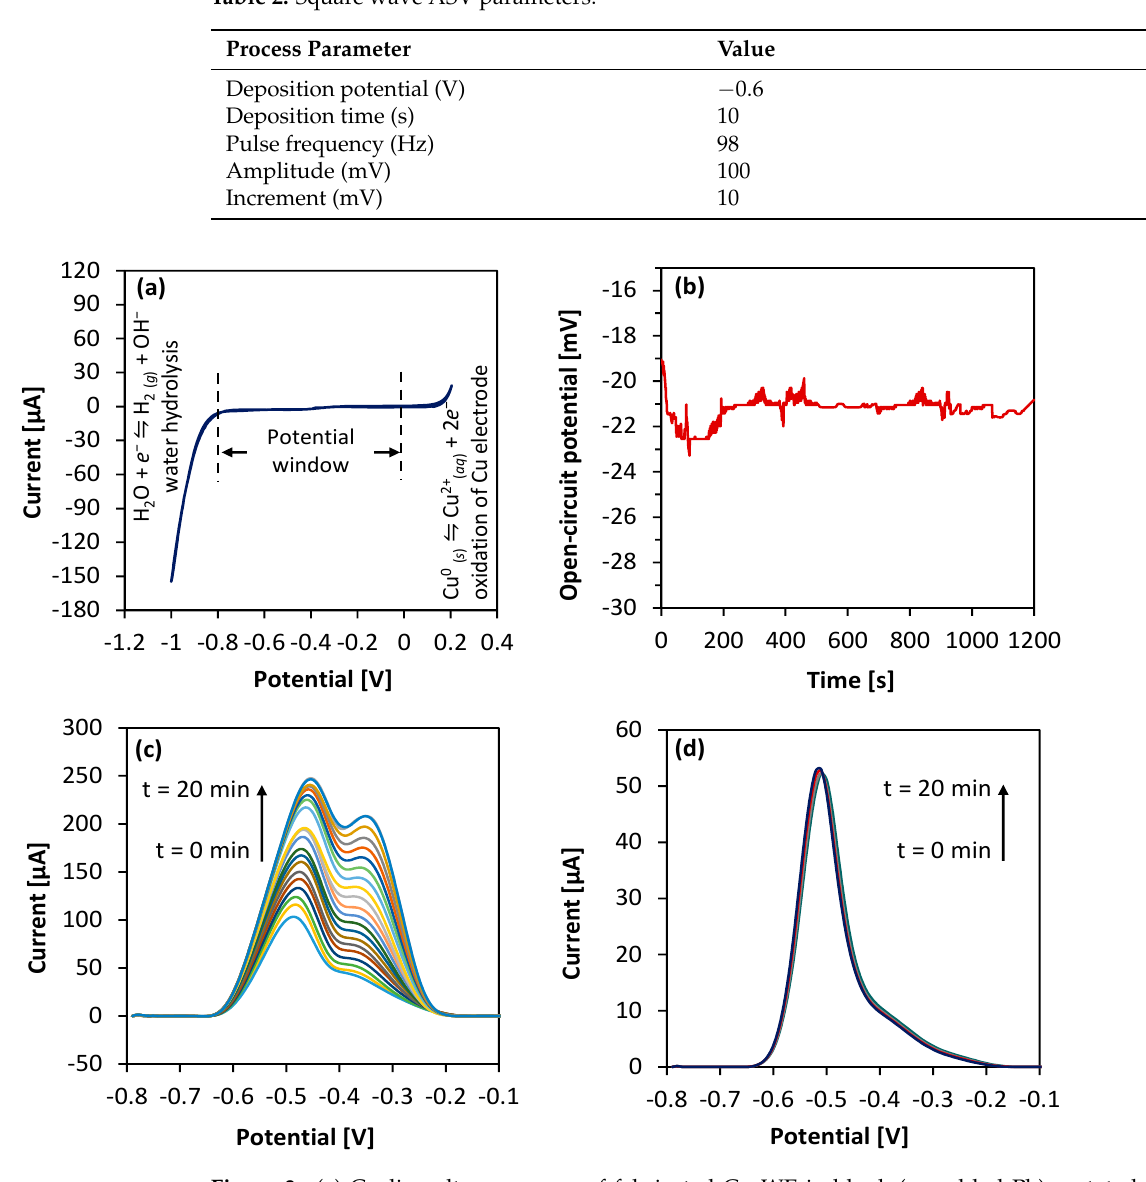
Figure 3. ( a ) Cyclic voltammogram of fabricated Cu WE in blank (no added Pb) acetate buffer. Scan rate was 100 mV/s, sweep voltage = − 1 V to + 0.2 V. ( b ) Open-circuit potential response of fabricated Cu/CuCl 2 RE measured against a commercial Ag/AgCl RE in acetate buffer. ( c ) ASV of 1× non-sealed Cu-based sensor with 1 mM Pb in non-deoxygenated buffer taken over 20 min repeatedly. ( d ) ASV of 1× sealed Cu-based sensor with 1 mM Pb in deoxygenated buffer taken over 20 min repeatedly. For ASV parameters, refer to Table 2.